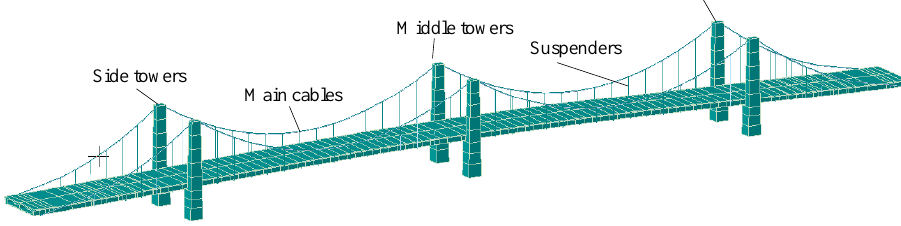
Figure 7. Finite element model.